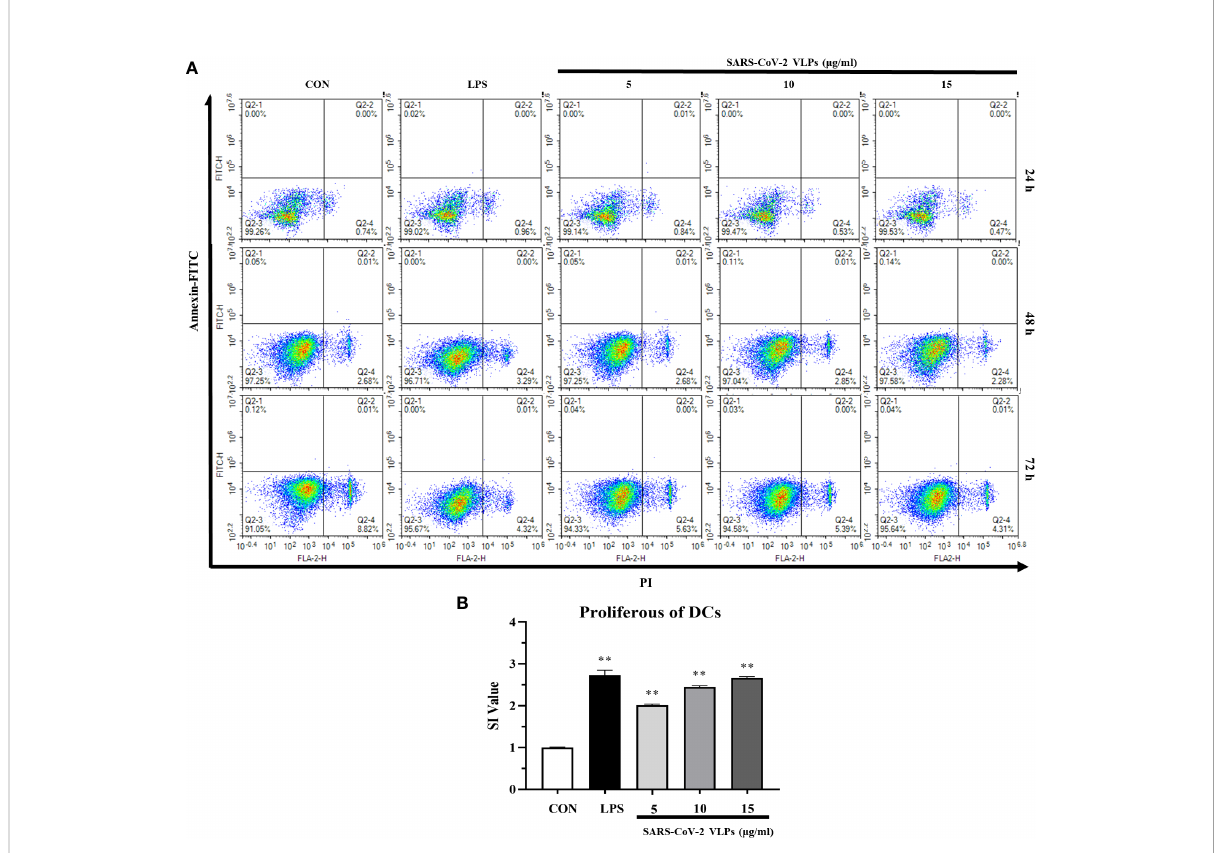
FIGURE 2 SARS-CoV-2 VLPs are not cytotoxic to dendritic cells (DCs) and stimulate DCs proliferation. (A) DCs were cultured with 5, 10, or 15 m g/mL SARS-CoV-2 VLPs for 24, 48, or 72 h. Then, the treated cells were stained with FITC – Annexin V and propidium iodide and analyzed via fl ow cytometry; untreated DCs are control (CON), and the percentage of cells is shown in each panel. (B) DCs were cultured with 5, 10, or 15 m g/mL SARS-CoV-2 VLPs for 24 h, and the proliferation of DCs was evaluated using the CCK-8 kit. The stimulation index (SI) value was applied to indicate the proliferation level of DCs. All data are expressed as means ± SE; ** P < 0.01 versus untreated control